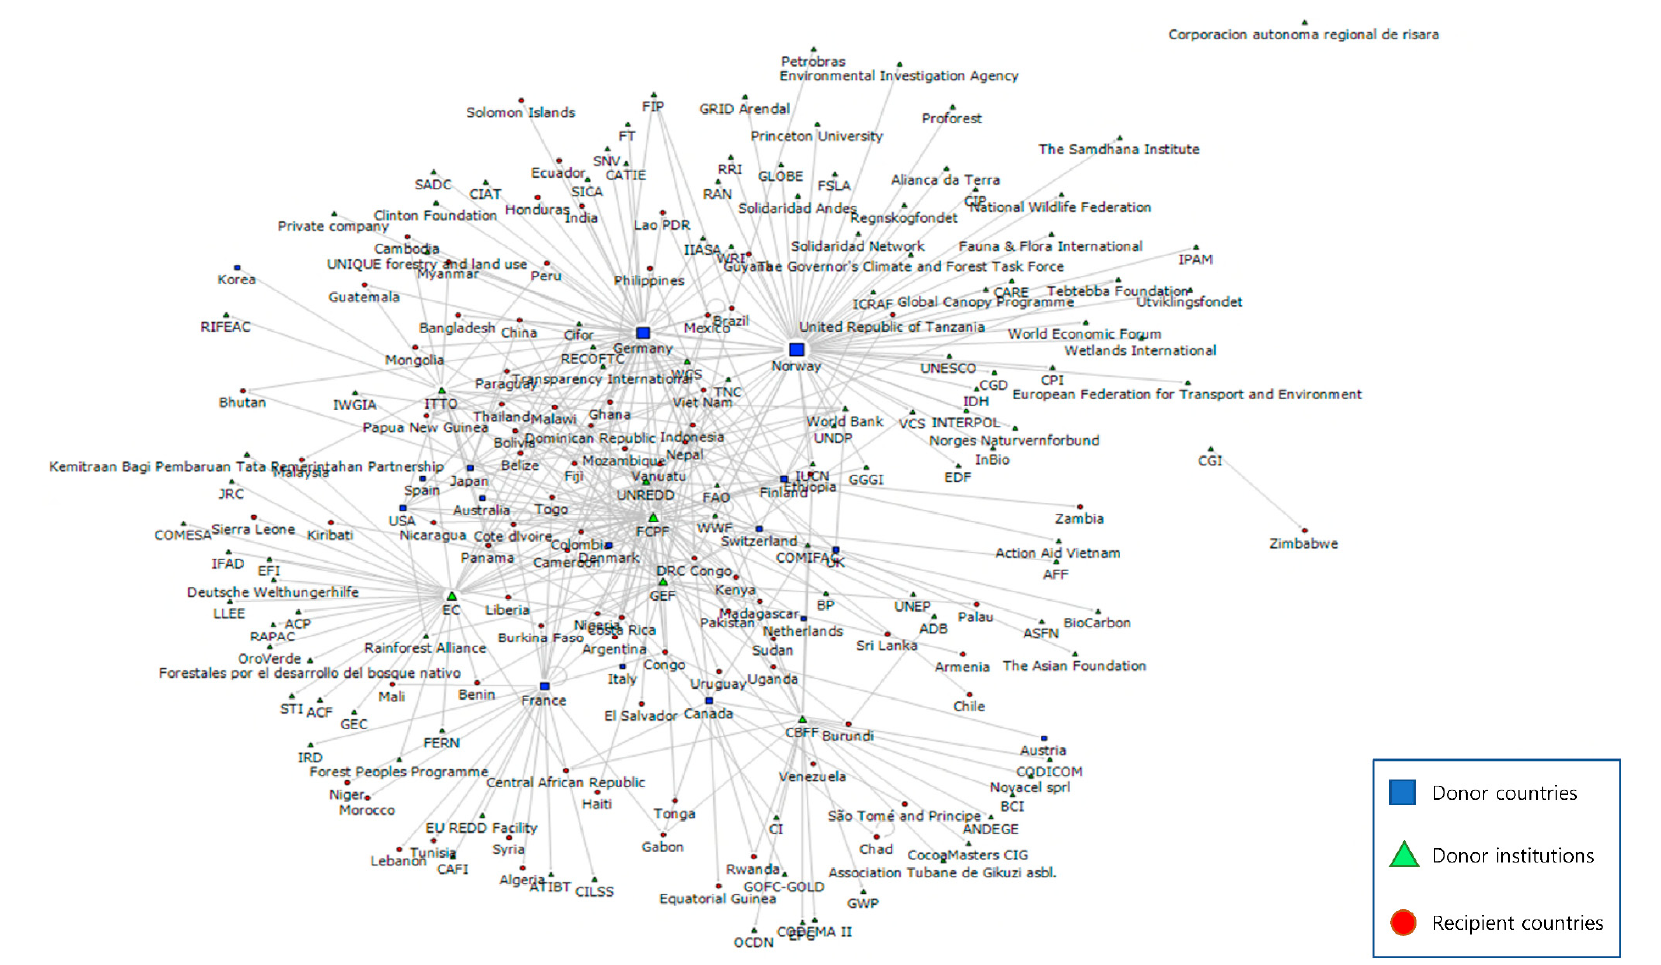
Figure 7. Out-degree centrality in global REDD+ financial network in 2015.